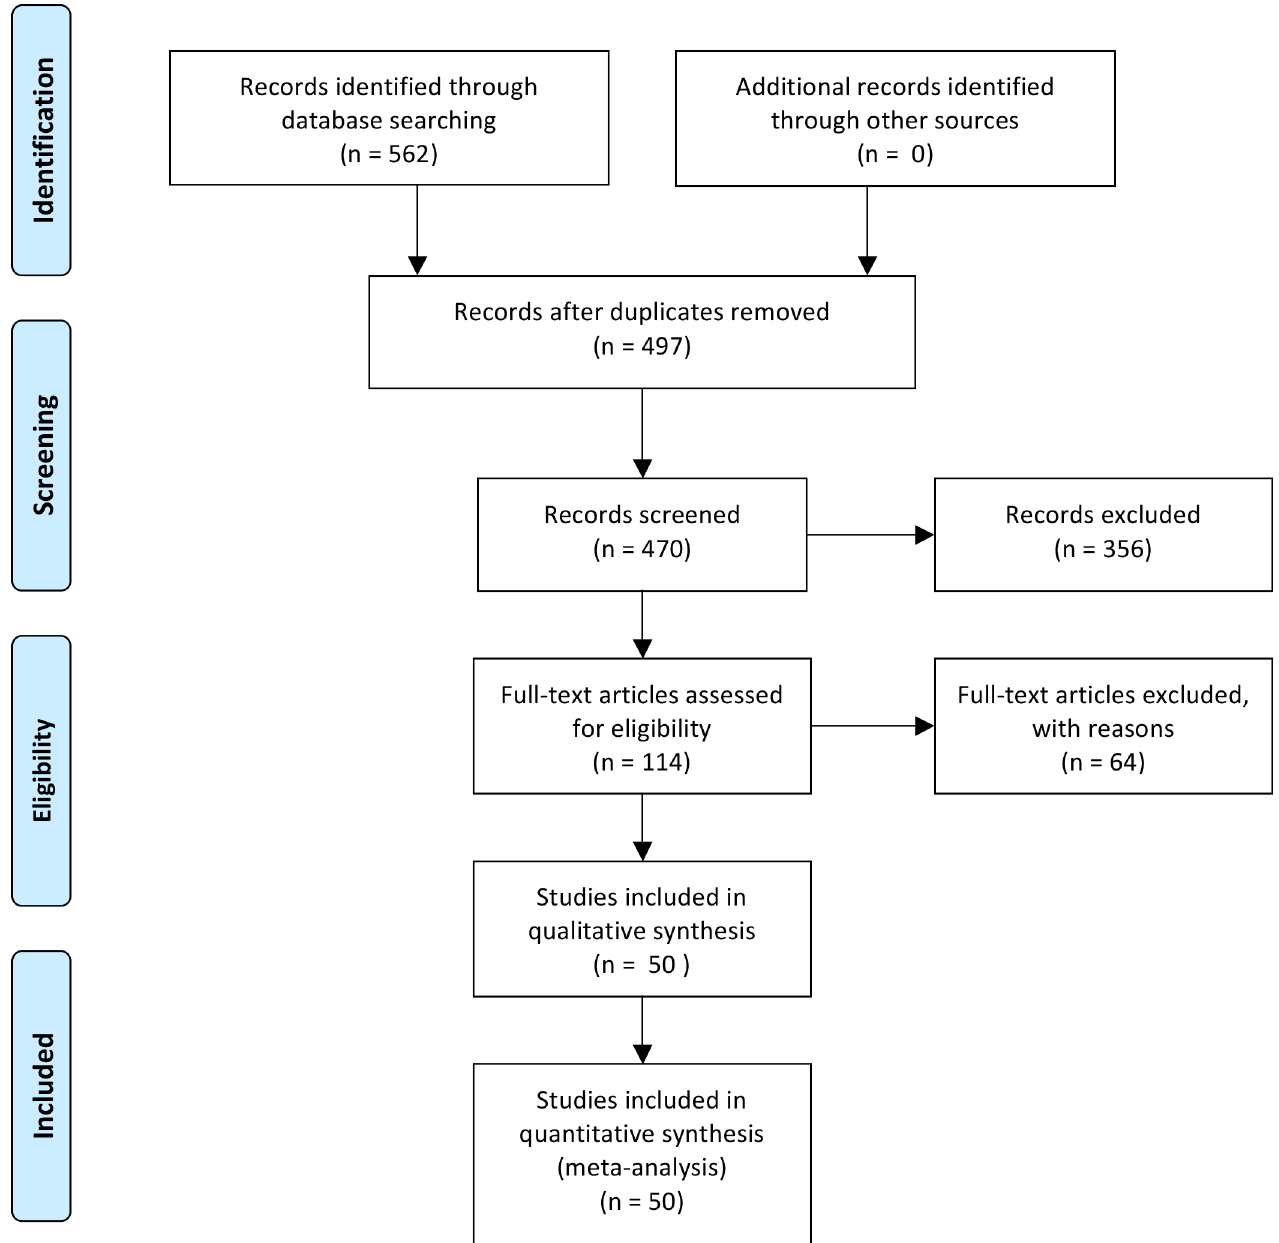
Fig 1. Flow diagram depicting systematic review search